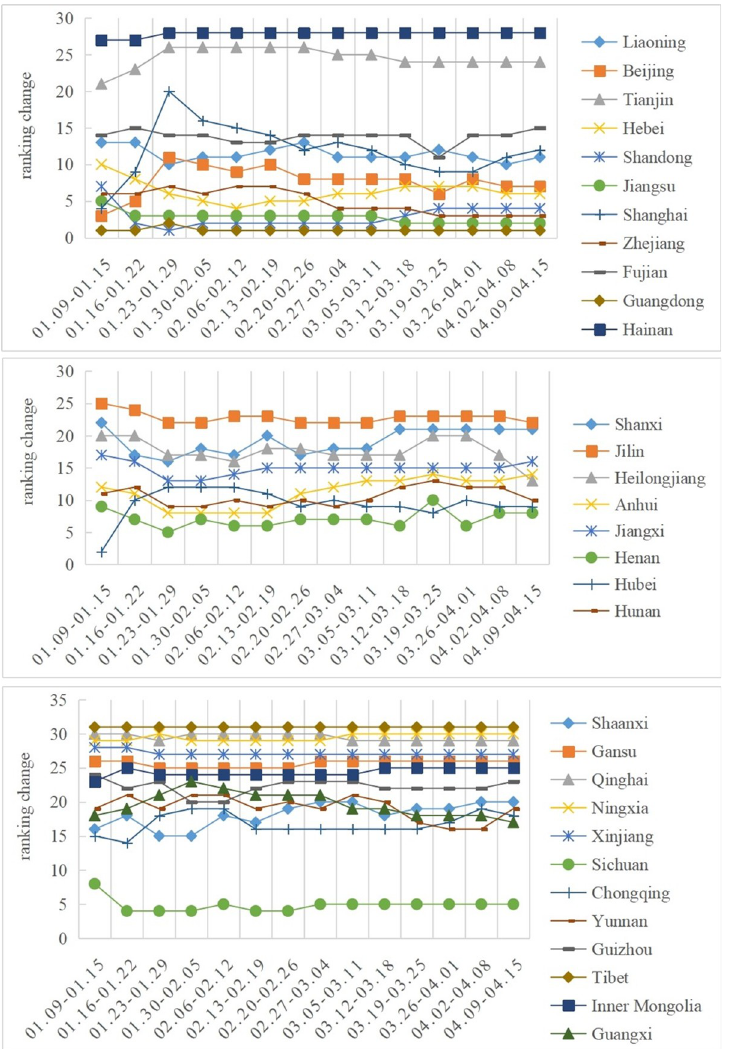
Fig 3. Sequence changes in the network attention level in 31 provinces. a: Sequence change in network attention in the eastern region. b: Sequence change in network attention in central region. c: Sequence change in network attention in the western